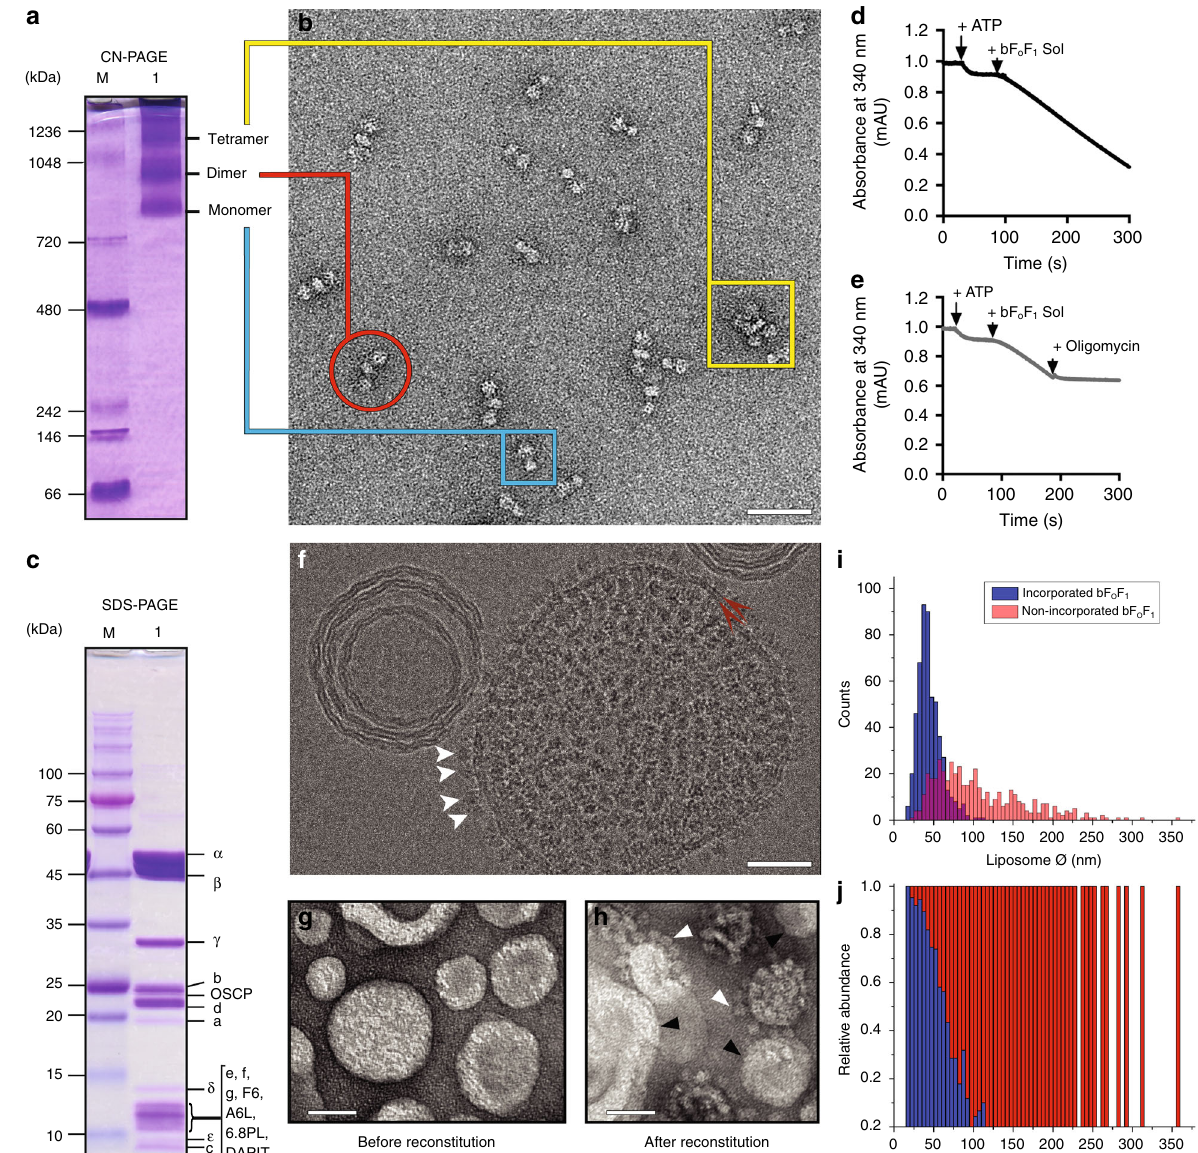
Fig. 1 Characterization of bovine F-ATP synthase. a Clear-native gel electrophoresis indicates the presence of monomeric, dimeric, and oligomeric bovine F- ATP synthase, and the absence of subcomplexes or other smaller protein complexes. Lane M: molecular weight markers (kDa); Lane 1: F-ATP synthase (30 μ g). b Negative stain EM documents the presence of bovine F-ATP synthase monomers (blue rectangle), dimers (red circle), and tetramers